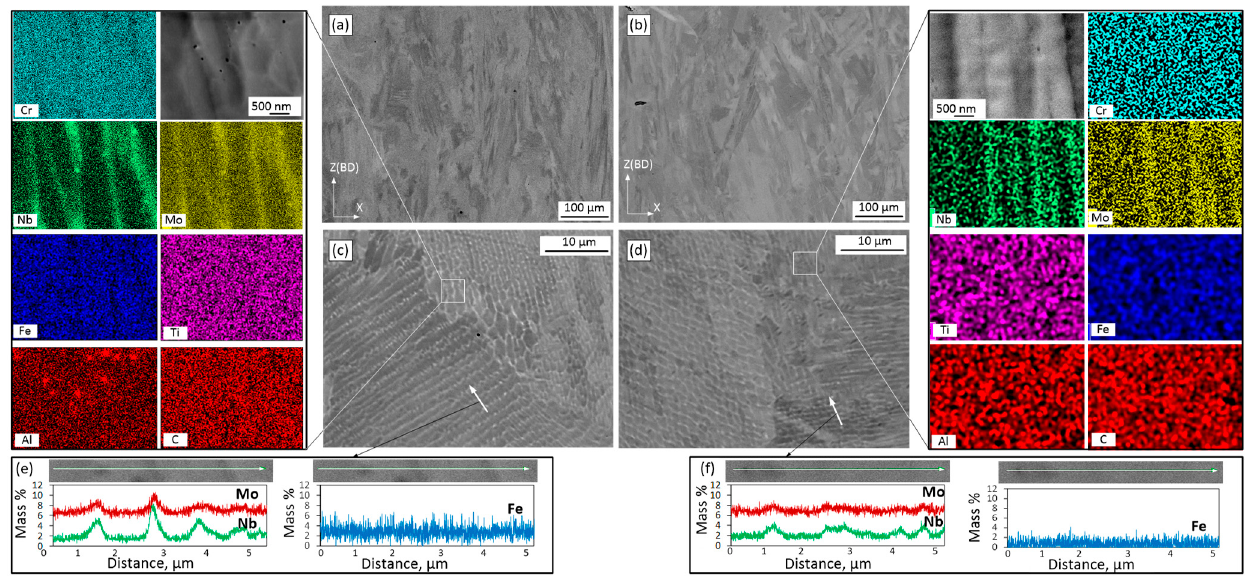
Figure 3. Microstructure and microsegregation patterns (in ZX plane) of the as-built alloys: ( a , b ) low resolution micrographs; ( c , d ) high resolution micrograph with elemental maps; ( e , f ) EDX line scans of Alloy 1 and Alloy 2.